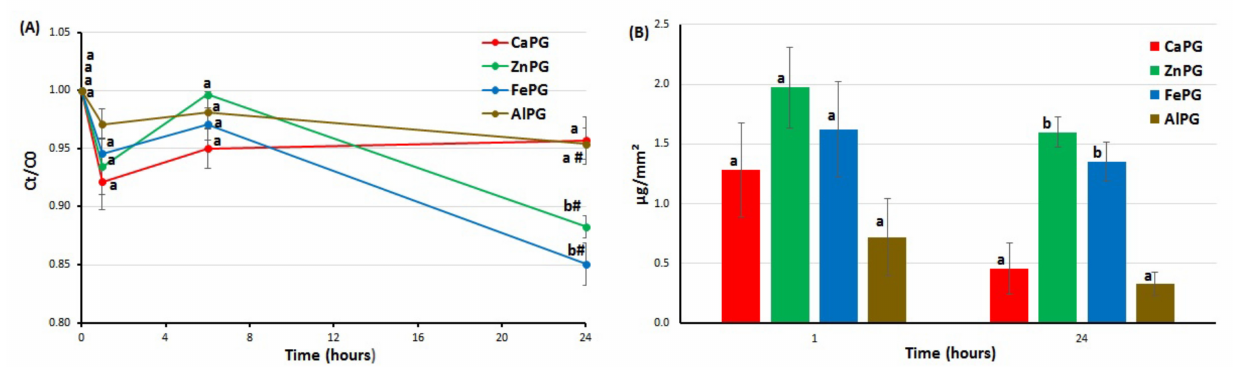
Figure 4. The serum protein adsorption by CaPG, ZnPG, FePG, and AlPG beads incubated for 24 h in RPMI-1640 medium supplemented with 10% FBS. Adsorption is expressed as the relative protein concentration Ct/C0 ( A ) and as protein adsorption per unit surface area ( B ). The data are presented as the mean ± SD ( n = 5). Different letters indicate significant differences between pectin gel beads prepared with different cations ( p < 0.05). # p < 0.05 vs. previous time point. C0 and Ct are the initial and remaining concentrations of protein in solution at different time points after incubation,